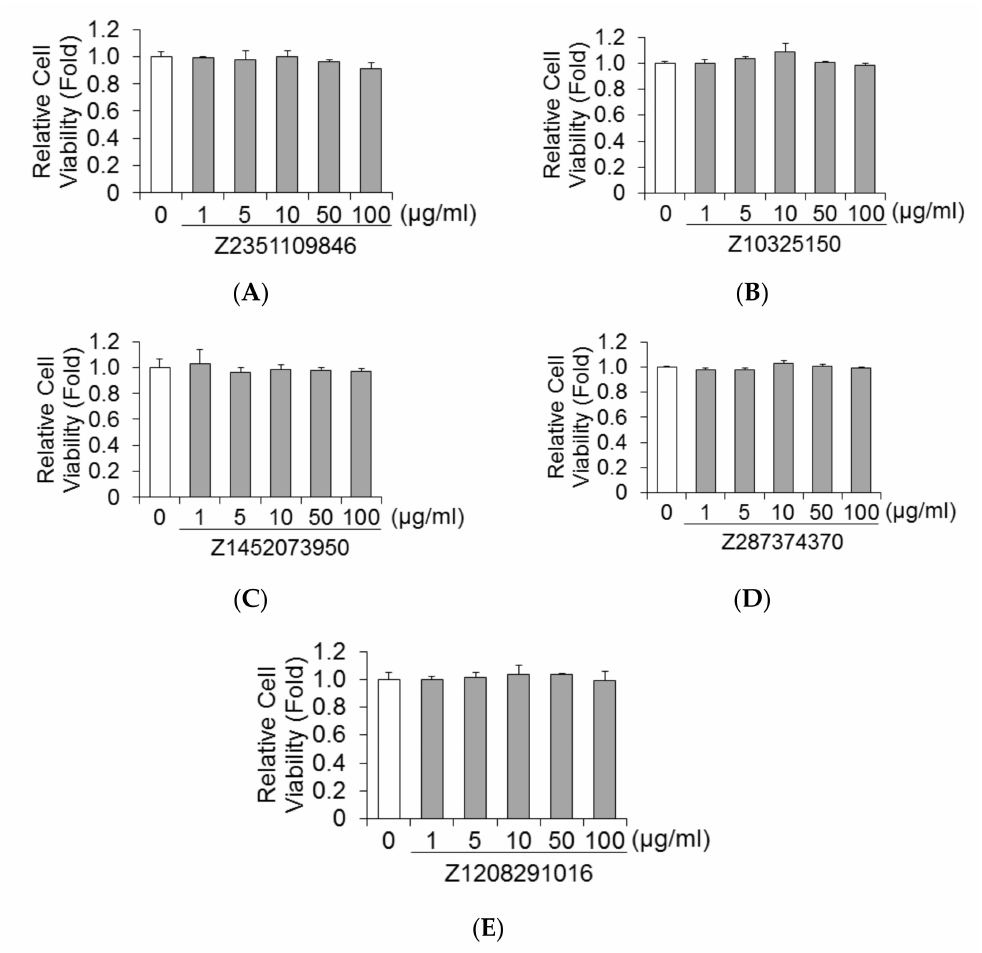
Figure 2. Effects of Z2351109846, Z10325150, Z1452073950, Z287374370, and Z1208291016 on cell viabilities of HuhT7 cells. Cell viabilities of HuhT7 cells treated with Z2351109846 ( A ), Z10325150 ( B ), Z1452073950 ( C ), Z287374370 ( D ), and Z1208291016 ( E ). HuhT7 cells were treated with each drug for 48 h. Cell viabilities were determined via dimethylthiazol carboxymethoxyphenyl sulfophenyl tetrazolium (MTS) assay. Data are expressed as means and standard deviations of triplicate de- terminations from three independent experiments. Statistical significance was analyzed using the two-tailed Student’s t